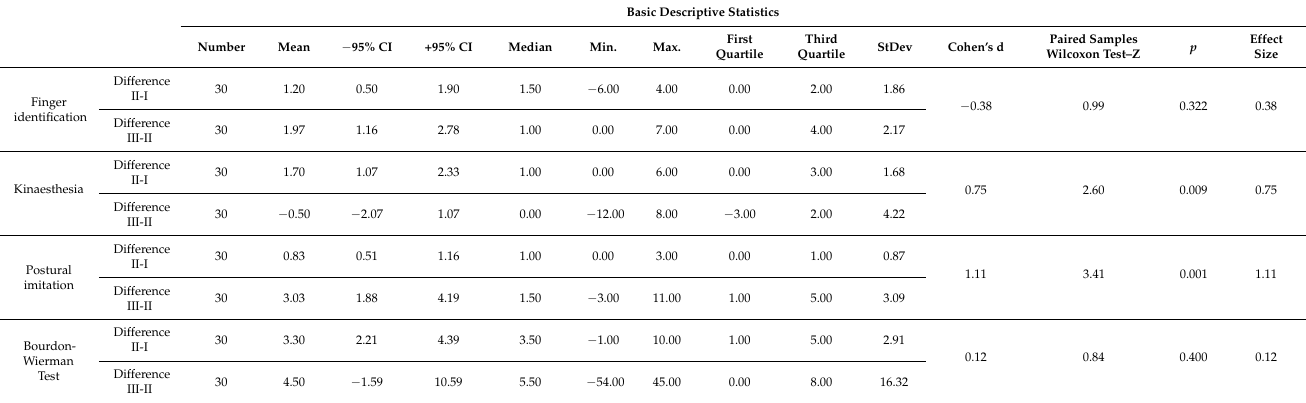
Table 10. Comparison of the therapy effects, short-term and